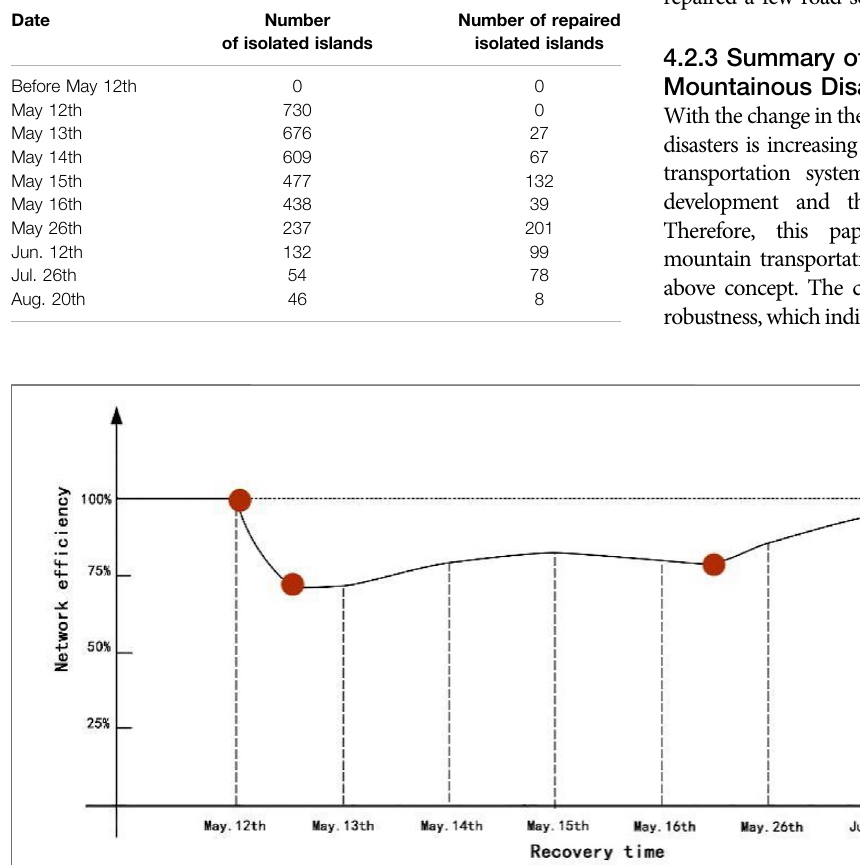
FIGURE 12 | Adaptive resilience curve characterized by network ef fi